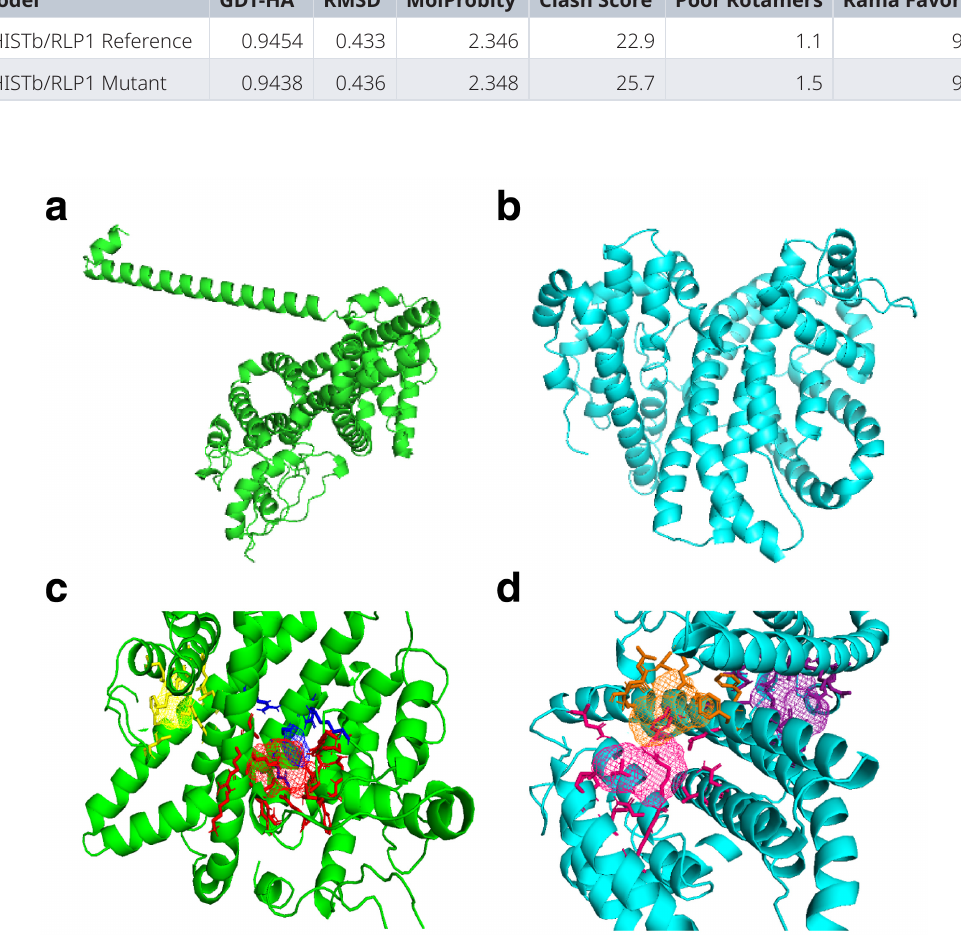
Figure 2. PHISTb/RLP1 reference and mutant homology modelled structures and their predicted binding sites clusters. ( a ) PHISTb/RLP1 reference protein structure shown in green; ( b ) structure of PHISTb/RLP1 mutant protein structure shown in cyan; ( c ) PHISTb/RLP1 reference protein binding site clusters, site 1 in red, site 2 in blue and site 3 in yellow; ( d ) PHISTb/RLP1 mutant protein binding sites clusters, site 1 in pink, site 2 in orange and site 3 in dark purple. All models visualized in PyMOL.